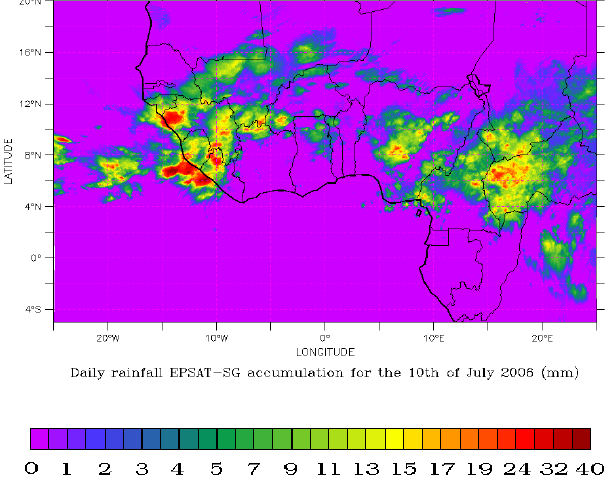
Fig. 13a. Daily cumulated EPSAT-SG rainfall estimation. Figure 13.a. Daily cumulated EPSAT-SG rainfall estimation. 8 Validation